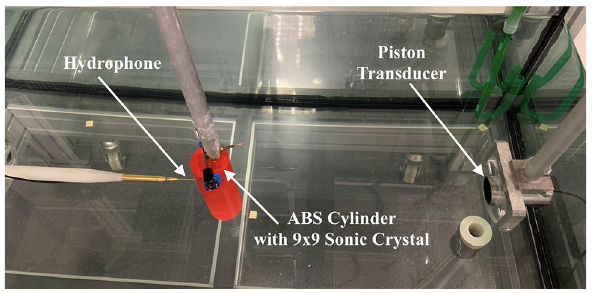
Figure 7. Photography with the detail of the different parts of the experimental